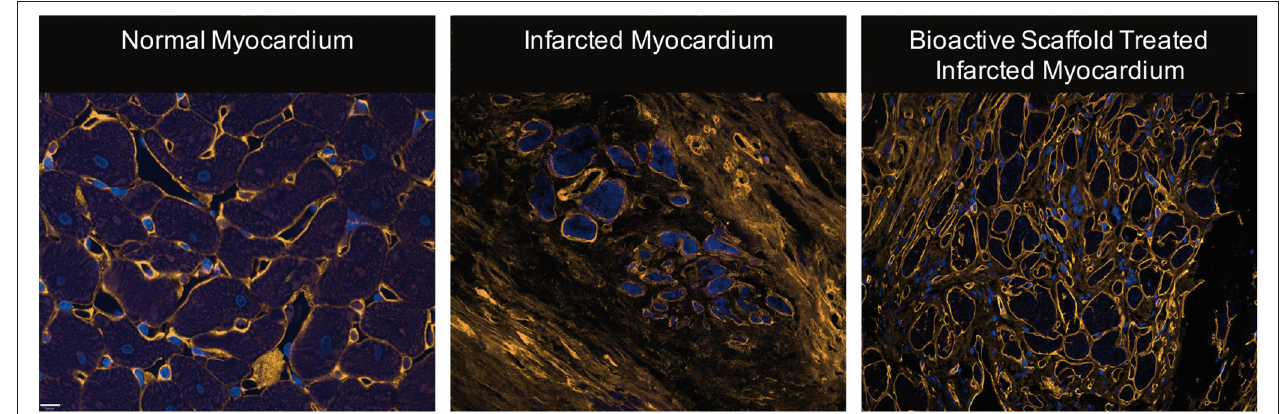
figURe 1 | Representative images of normal myocardium, infarcted myocardium from a sham, and infarcted myocardium following surgical implantation of bioactive scaffold on the epicardial surface (blue = nucleus, orange = collagen). The infarct area of bioactive scaffold-treated animals showed less collagen density and ECM architecture more consistent with normal cardiac tissue (Reprinted from The Journal of Thoracic and Cardiovascular Surgery, Vol 147/Issue 5, Holly EM Mewhort, Jeannine D Turnbull, Christopher Meijndert, Janet MC Ngu, Paul WM Fedak, Epicardial infarct repair with basic fibroblast growth factor–enhanced CorMatrix-ECM biomaterial attenuates postischemic cardiac remodeling, 1650–1659., Copyright 2014, with permission from Elsevier) (28).